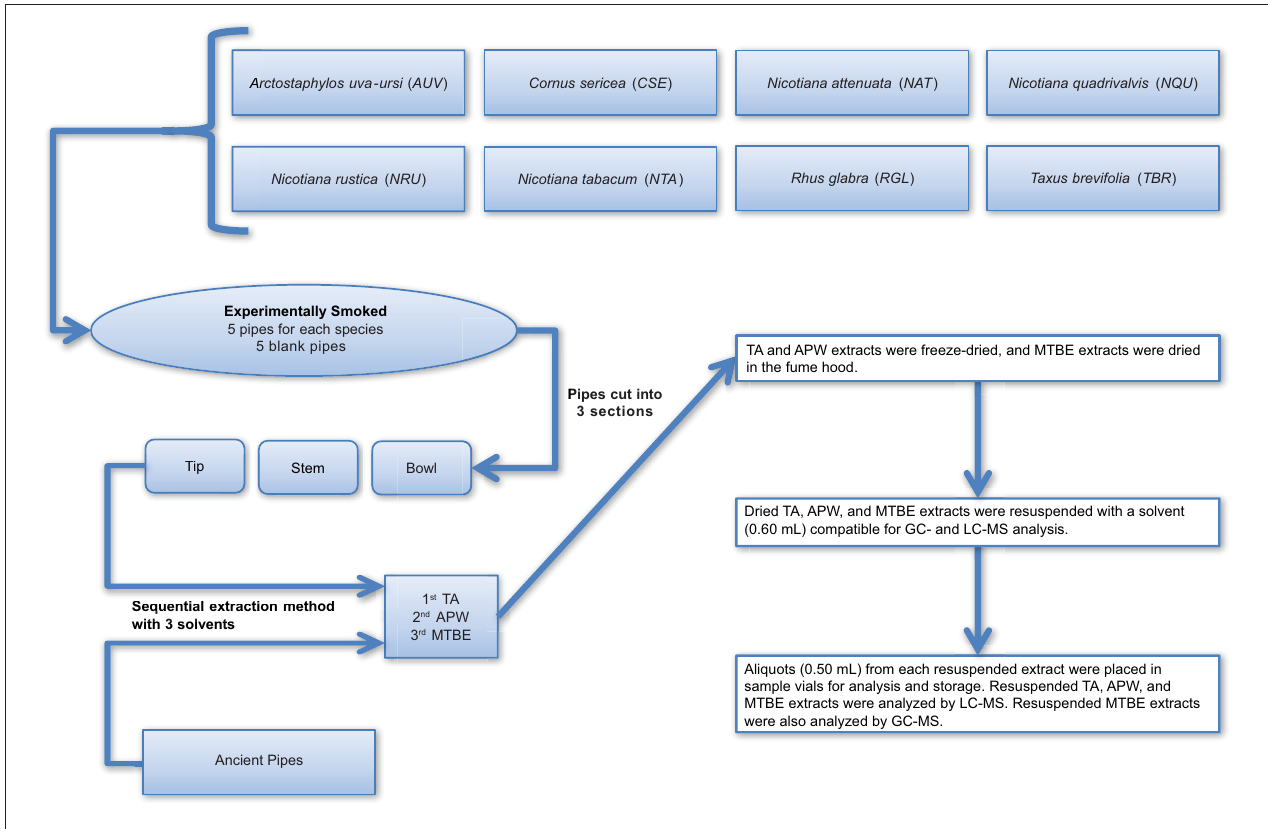
FIGURE 2 | Workflow illustrating how the experimental and ancient pipes were prepared for extraction and analysis. TA, APW, and MTBE correspond to 2% aqueous tartaric acid, acetonitrile:2-propanol:water [3:2:2], and methyl tert -butyl ether, respectively.